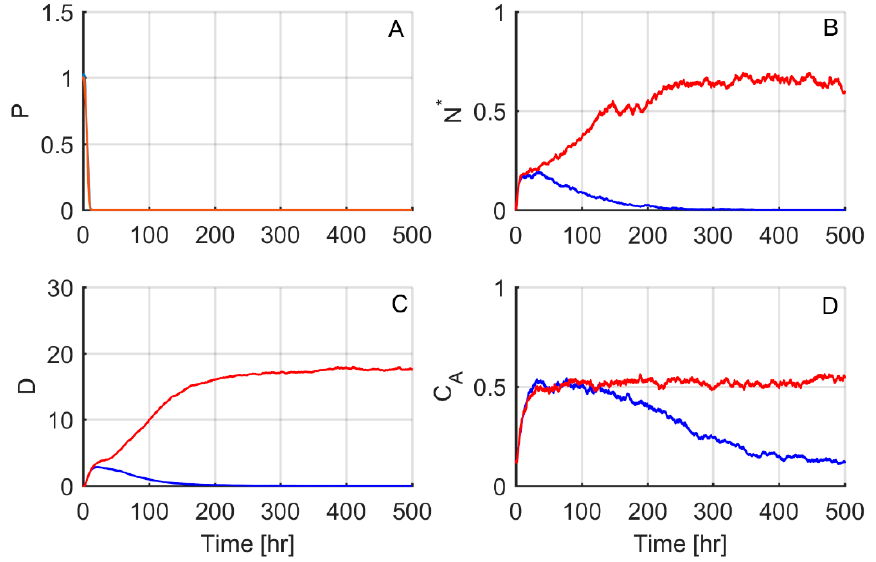
Figure 2. A stochastic bifurcation leads to resolving and non-resolving responses. The responses of all four model variables ( A – D ) are shown for two different stochastic simulations, one that resolved to the healthy steady state (blue lines) and one to the aseptic death steady state (red lines). Parameters and initial conditions were set equal to the “healthy outcome” case of [17].